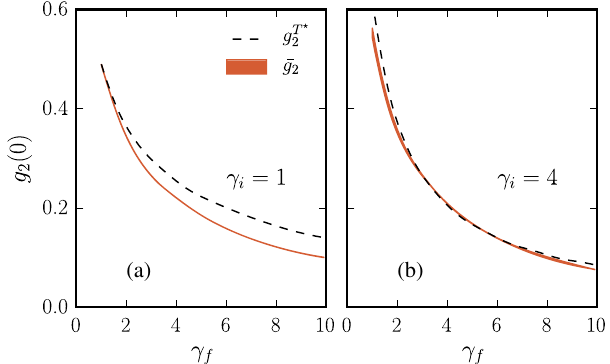
FIG. 3. Time-dependent expectation value of local two-body correlations after a quantum quench from the interacting ground 1 (a) and γ 4 (b). Long-term dynamical averages state at γ i ¼ i ¼ (red continuous lines) are compared to thermal averages at the effective temperature set by energy conservation (black dashed lines). Uncertainties on the thermal averages are of the order of the line width, and are larger for small values of γ f